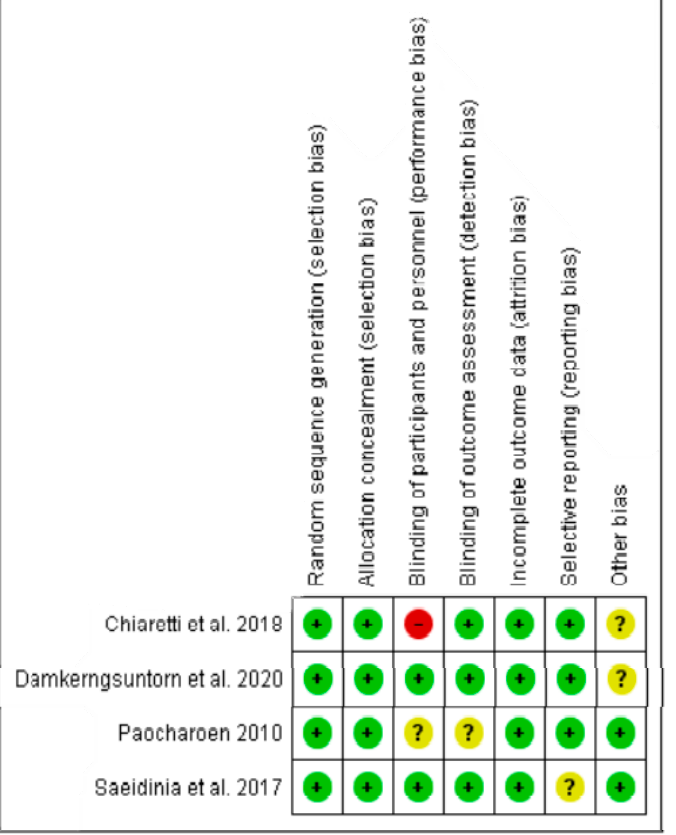
Figure 3. Risk of bias summary for the included studies on Centella asiatica . Low risk of bias (+), unclear risk of bias (?), and high risk of bias ( − ).